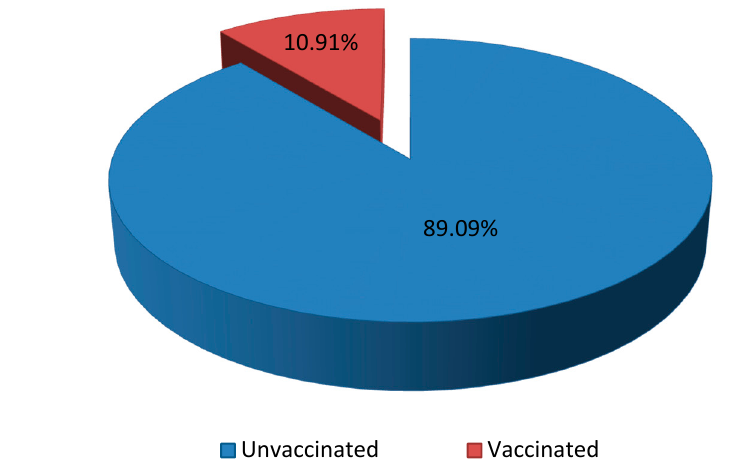
Figure 13. Percentage of unvaccinated people worldwide as of 1 June 2021.